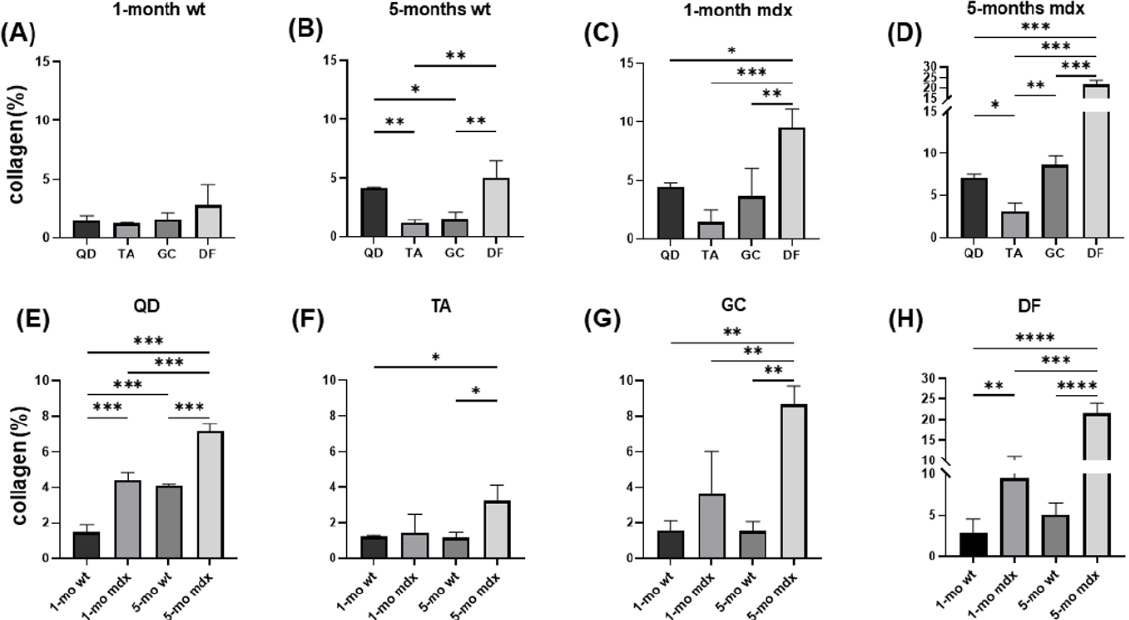
Figure 2. Bar graphs showing the effect of age on collagen content in sections of QD, TA, GC, DF muscles of wt and mdx mice at different age stained with Sirius red. Collagen content was assessed in the endomysium and is expressed as %. Data are mean ± SD. * p < 0.05; ** p < 0.01; *** p < 0.005; **** p < 0.001.